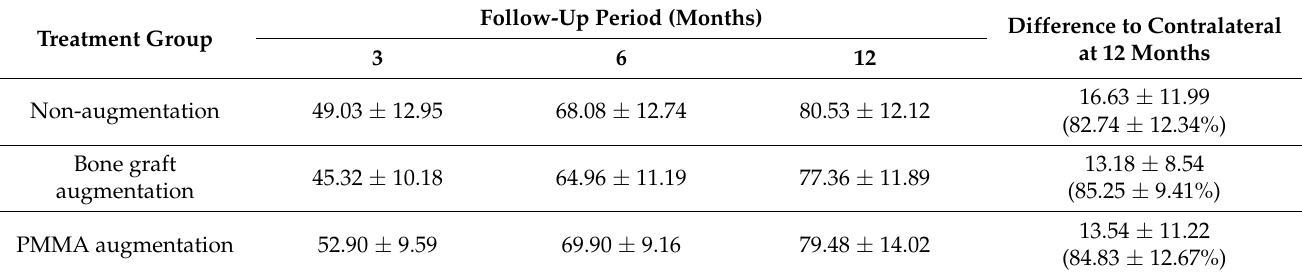
Table 4. CS score in the treatment groups at three different follow-up periods, presented in terms of mean value and standard